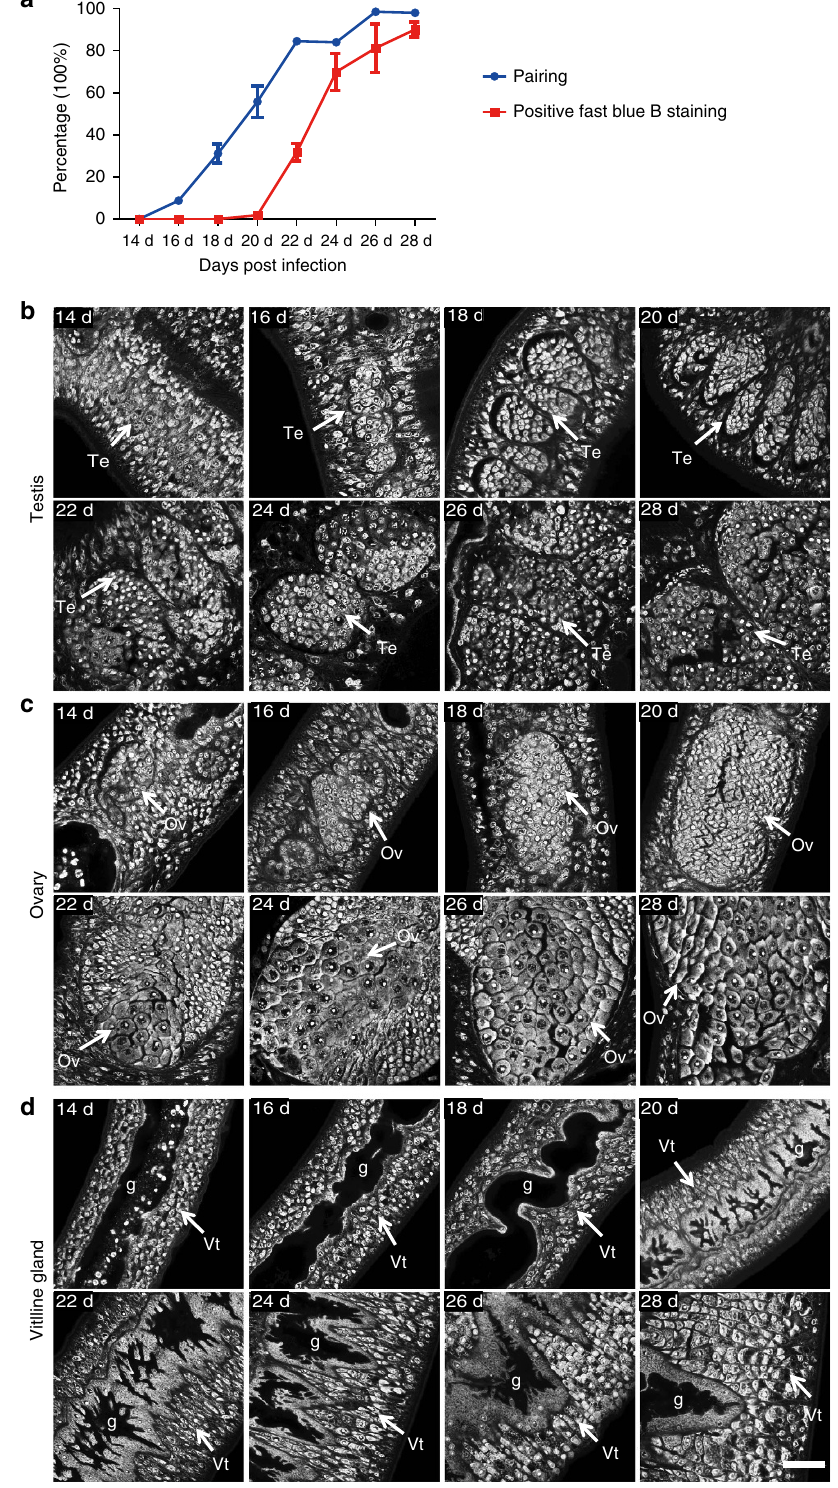
Figure 1 | In vivo male–female pairing and sexual development in S. japonicum . ( a ) Percentage of pairing and vitelline development from 14 to 28d.p.i. in vivo . Positive Fast Blue B staining indicates the mature vitelline cells (mean ± s.e.m., n ¼ 3). ( b – d ) Morphological changes in the reproductive system from 14 to 28d.p.i., as documented by confocal laser scanning micrographs of the ( b ) testis, ( c ) ovary and ( d ) vitelline gland. g, gut; Ov, ovary; Te, testis; Vt, vitelline cells. n 4 5 per experiment. Scale bar, 50 m